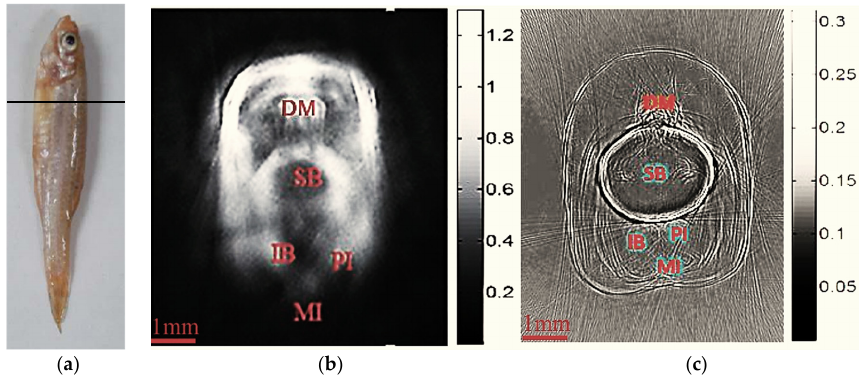
Figure 6. ( a ) The photograph of the adult zebrafish, in which the black line denotes the imaging slice of the zebrafish. The PA images were recovered by using 10 MHz unfocused transducer ( b ) and focused one ( c ). Here DM denotes dorsal muscles, SB denotes swim bladder, IB denotes intestinal bulb, PI denotes posterior intestine, and MI denotes mid intestine. The gray scale (right) records the PA signals in a relative unit whereas the color scale (right) illustrates the spatial scale, in